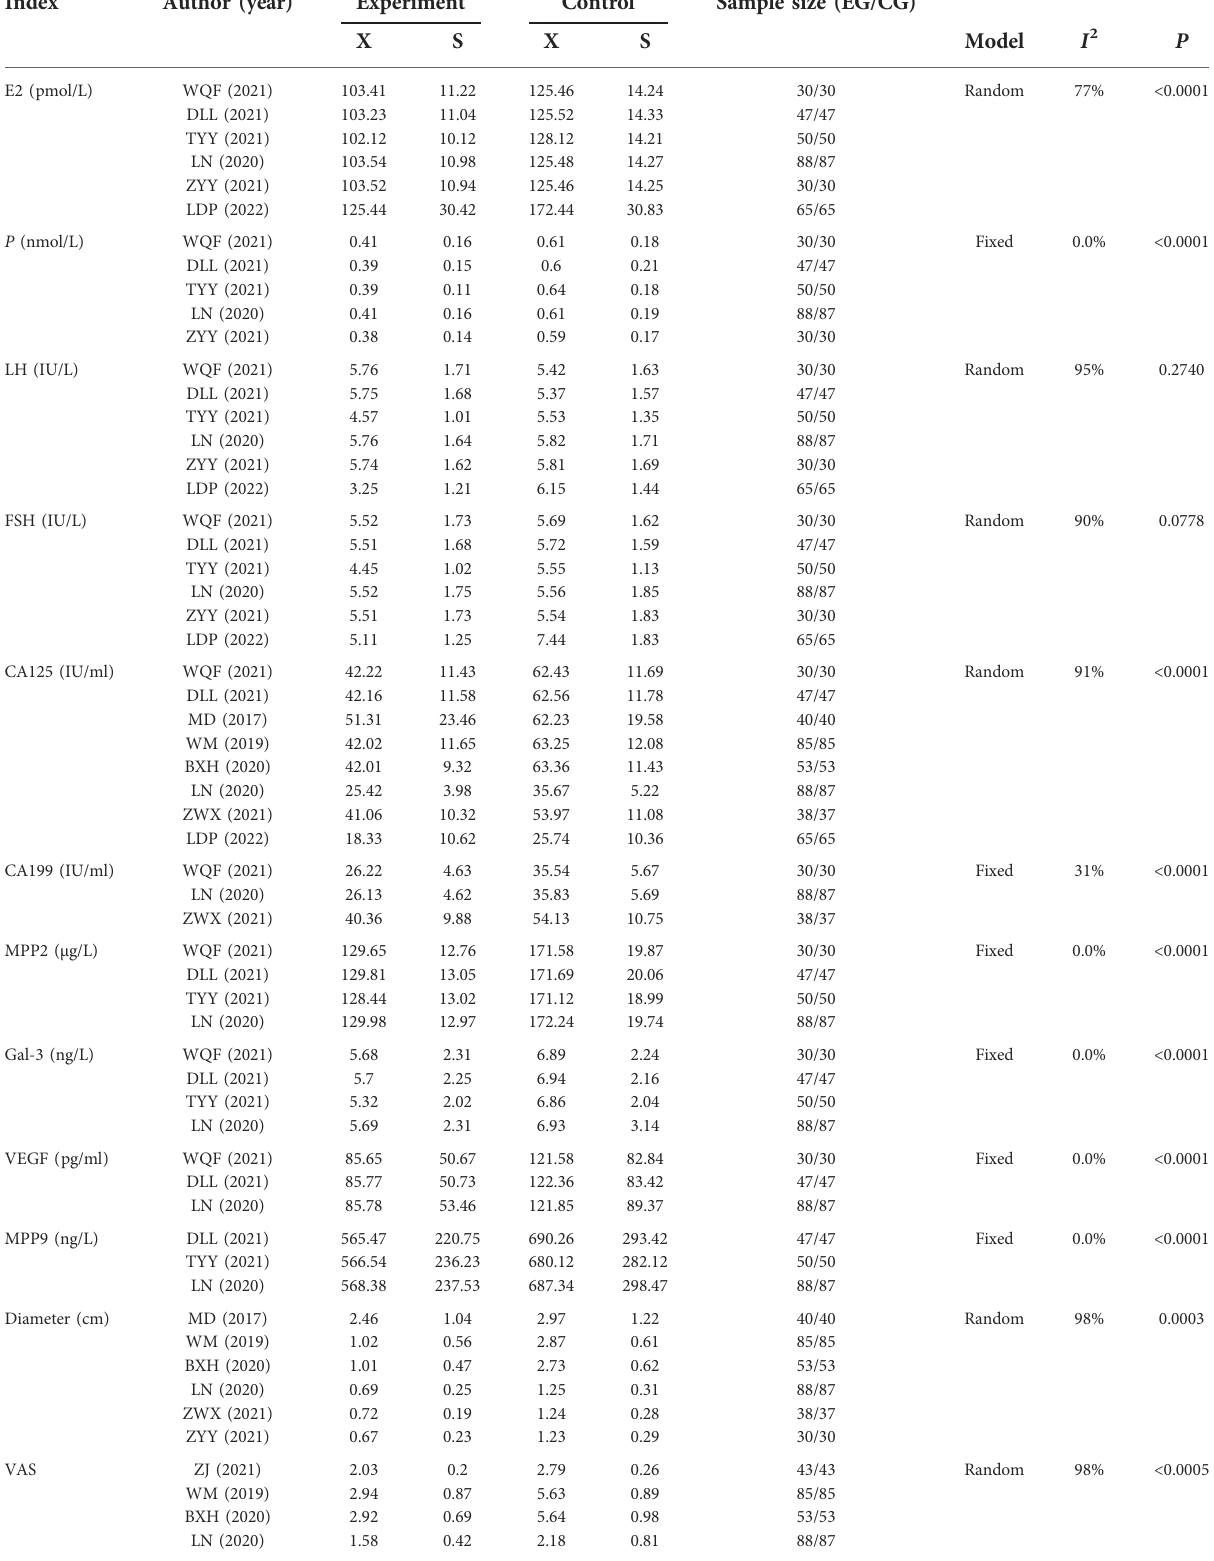
TABLE 3 Comparison of indicators after